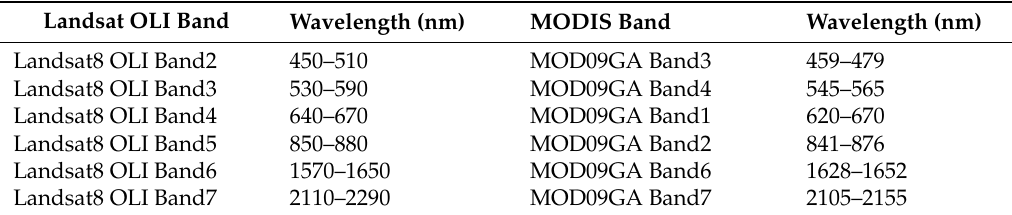
Table 2. Landsat8 OLI and MODIS data band comparison